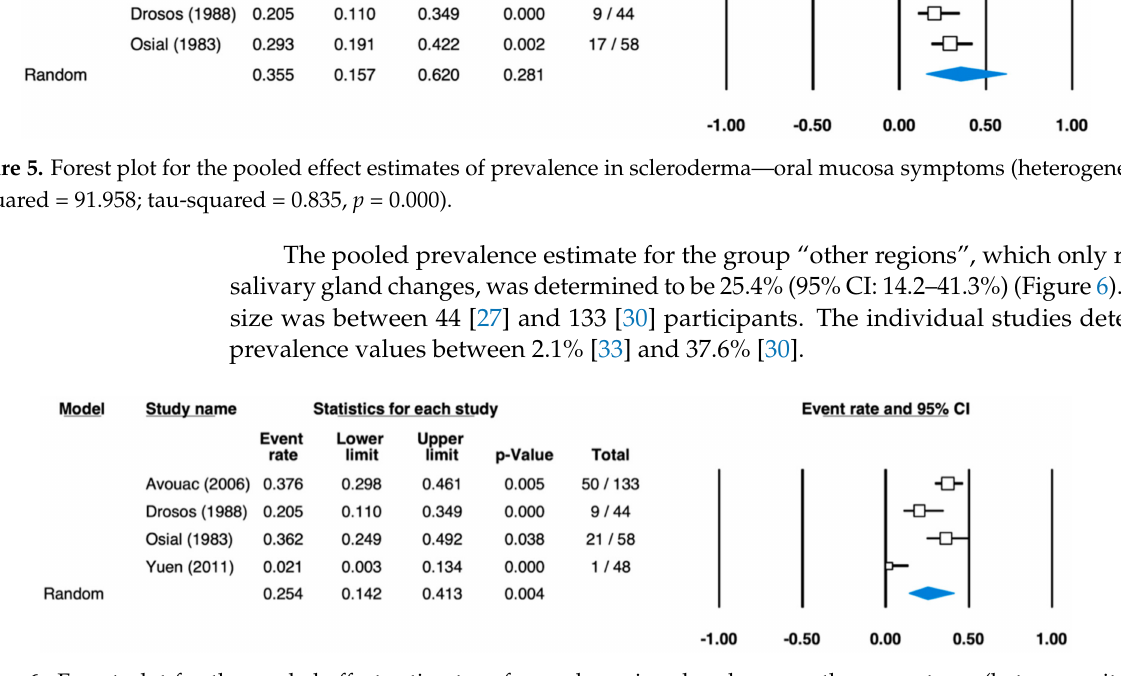
Figure 6. Forest plot for the pooled effect estimates of prevalence in scleroderma—other symptoms (heterogeneity: I- squared = 78.905; tau-squared = 0.375, p =